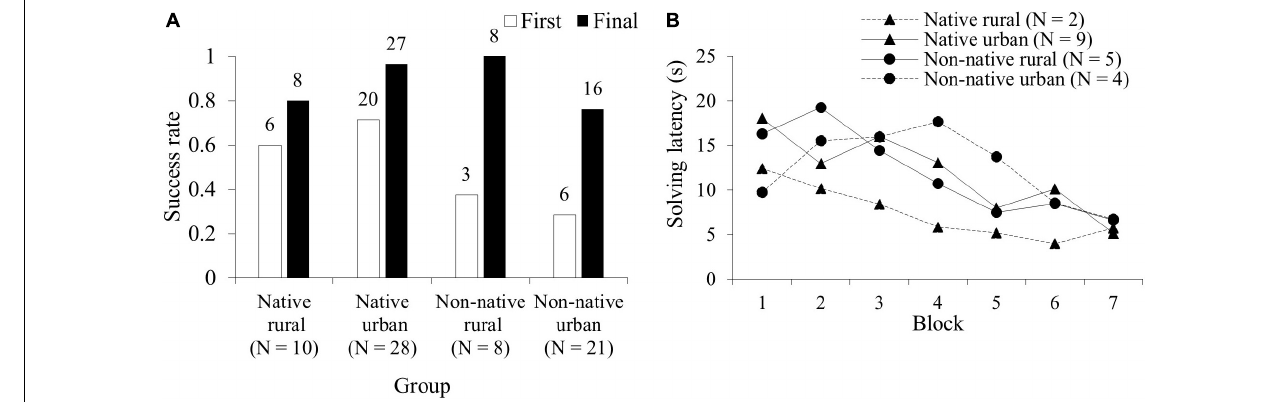
FIGURE 3 | Comparison of the performance in the difficult problem among the four squirrel groups (native rural, native urban, non-native rural, and non-native urban group). (A) Success rate (the number of innovators causing a lever/nut drop) on the first visit (First) and in the subsequent visits (Final), and (B) mean total latency to obtain a success (in seconds) across 7 blocks of 5 successes (35 successes).